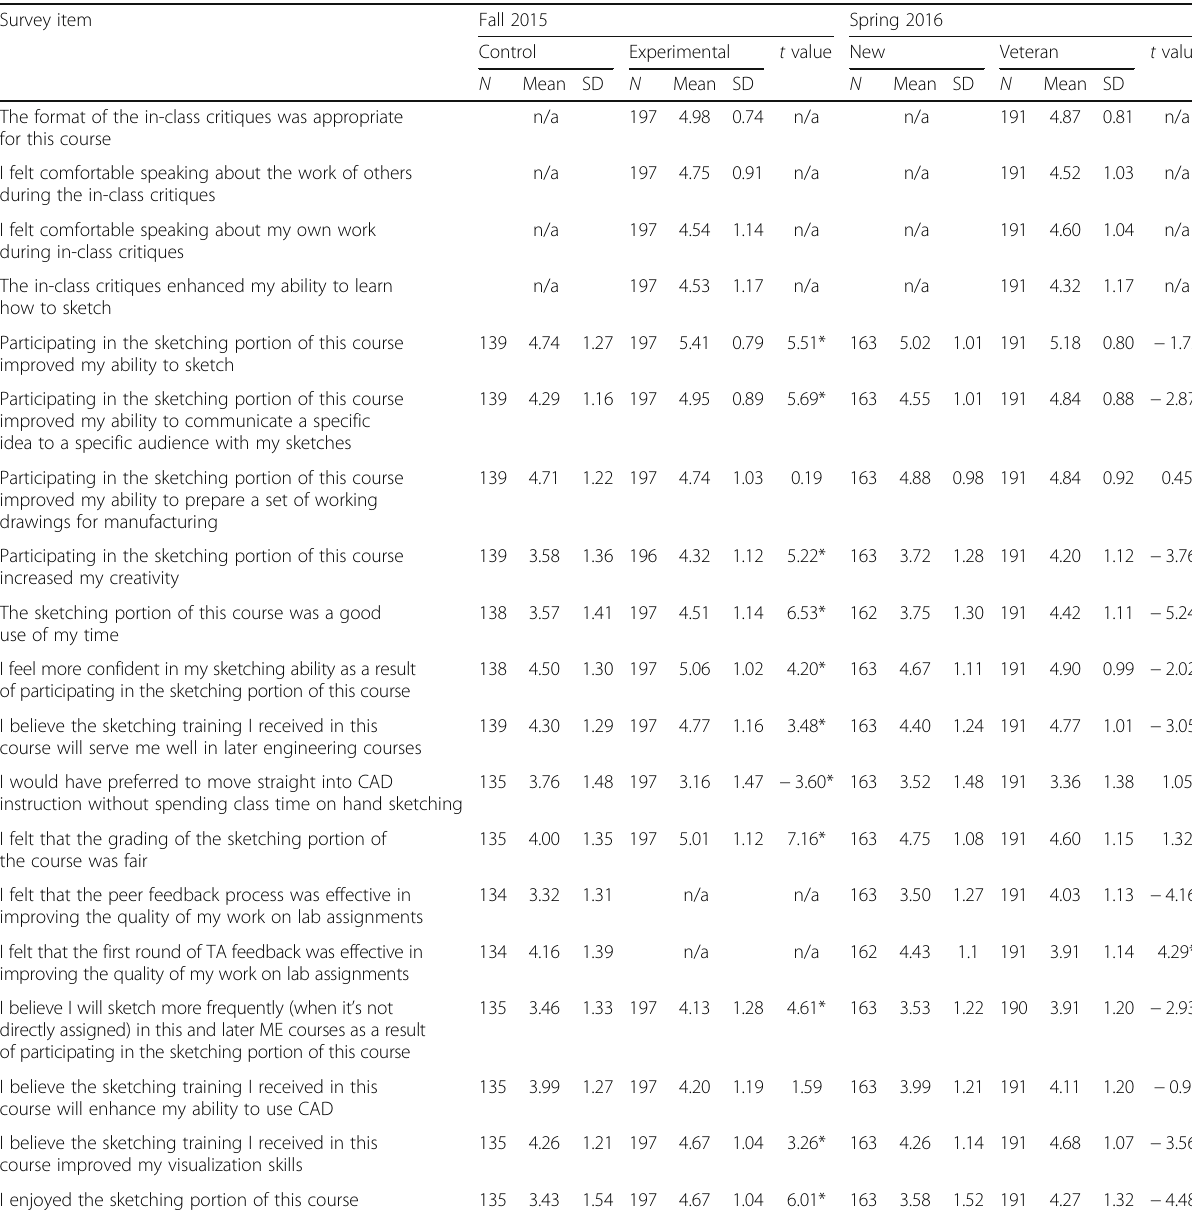
Table 1 Sketching survey results (Fall 2015 and Spring